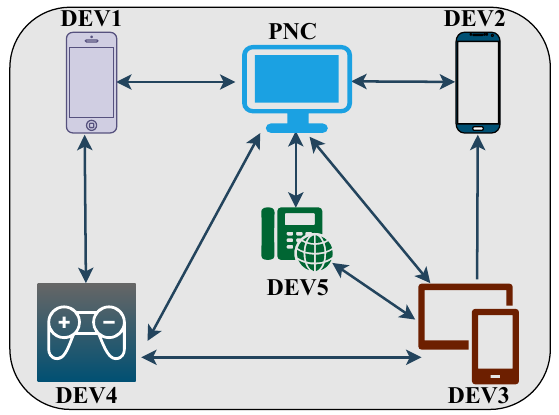
Figure 3. PNC and connecting devices for